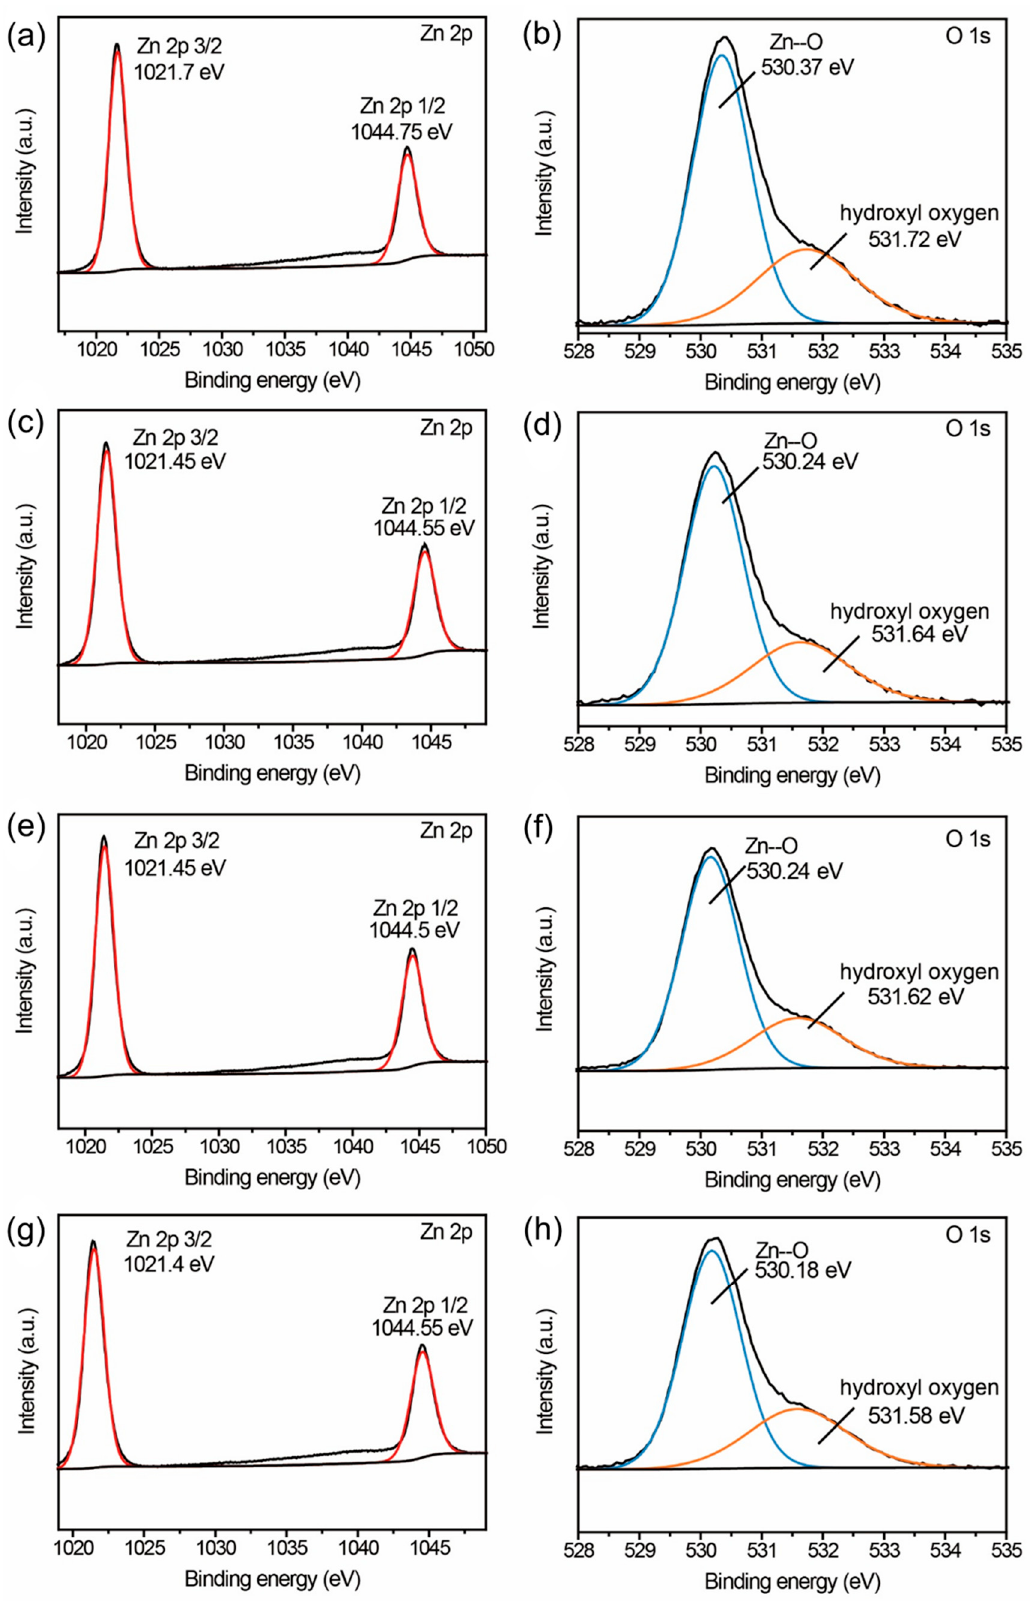
Figure 3. XPS spectra of ( a ) Zn 2p and ( b ) O 1s of ZnO short nanorods, ( c ) Zn 2p and ( d ) O 1s of ZnO nanowires, ( e ) Zn 2p and ( f ) O 1s of ZnO nanoflakes, ( g ) Zn 2p and ( h ) O 1s of ZnO nanospheres.